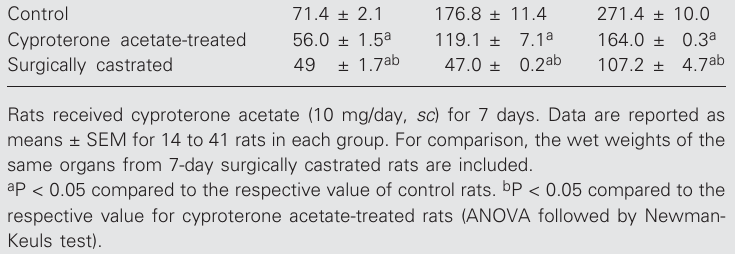
Table 1. Effect of cyproterone acetate treatment on the wet weights (in mg) of rat vas deferens, ventral prostate and seminal vesicle. Animals